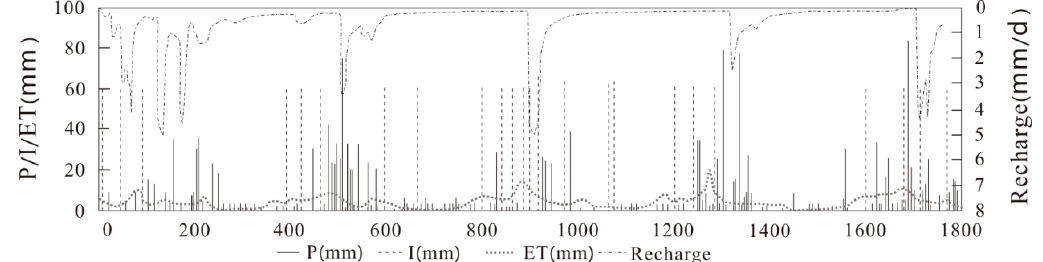
Figure 8. Recharge, precipitation, irrigation and evaporation varied with time, from 4 April 2003 to 27 September 2007 at the LC site. Table 4. Result of the hydraulic parameter estimation by the inverse method.